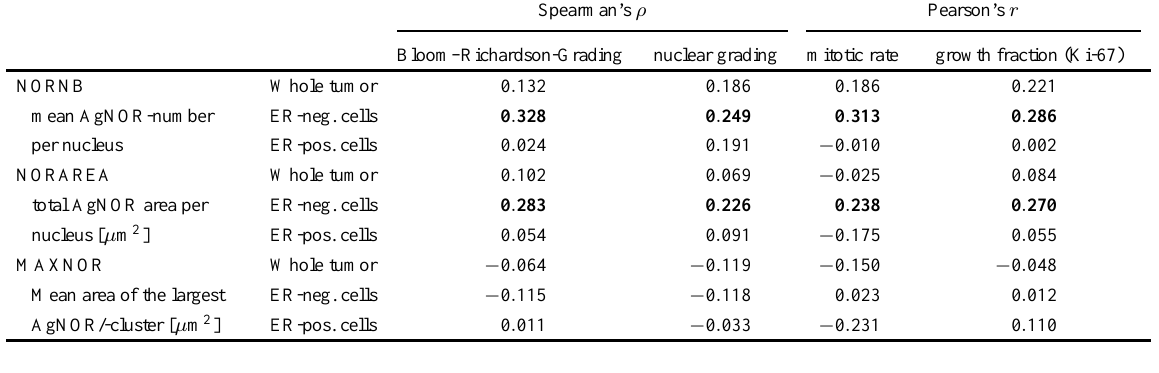
Correlation between AgNOR parameters (separately viewed for whole tumor; ER-neg cells and ER-pos cells) and other criteria of malignancy grade: Bloom–Richardson-Grading, nuclear grading, mitotic rate and growth fraction (Ki-67)